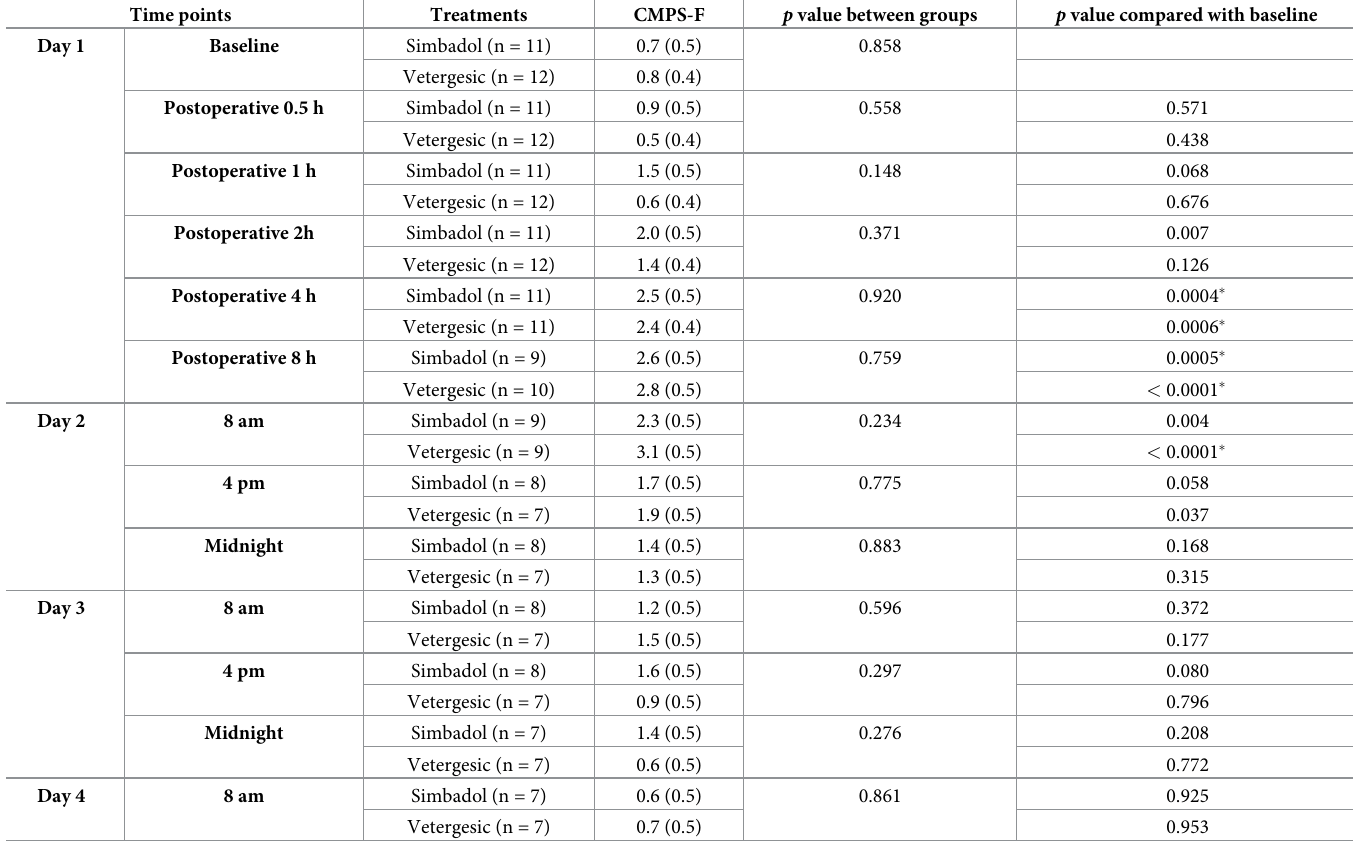
Table 5. Pain scores using the Glasgow Composite Measure Pain Scale-Feline (CMPS-F) in cats undergoing dental extractions after the administration of Simbadol or Vetergesic. Values are expressed as mean (SEM).